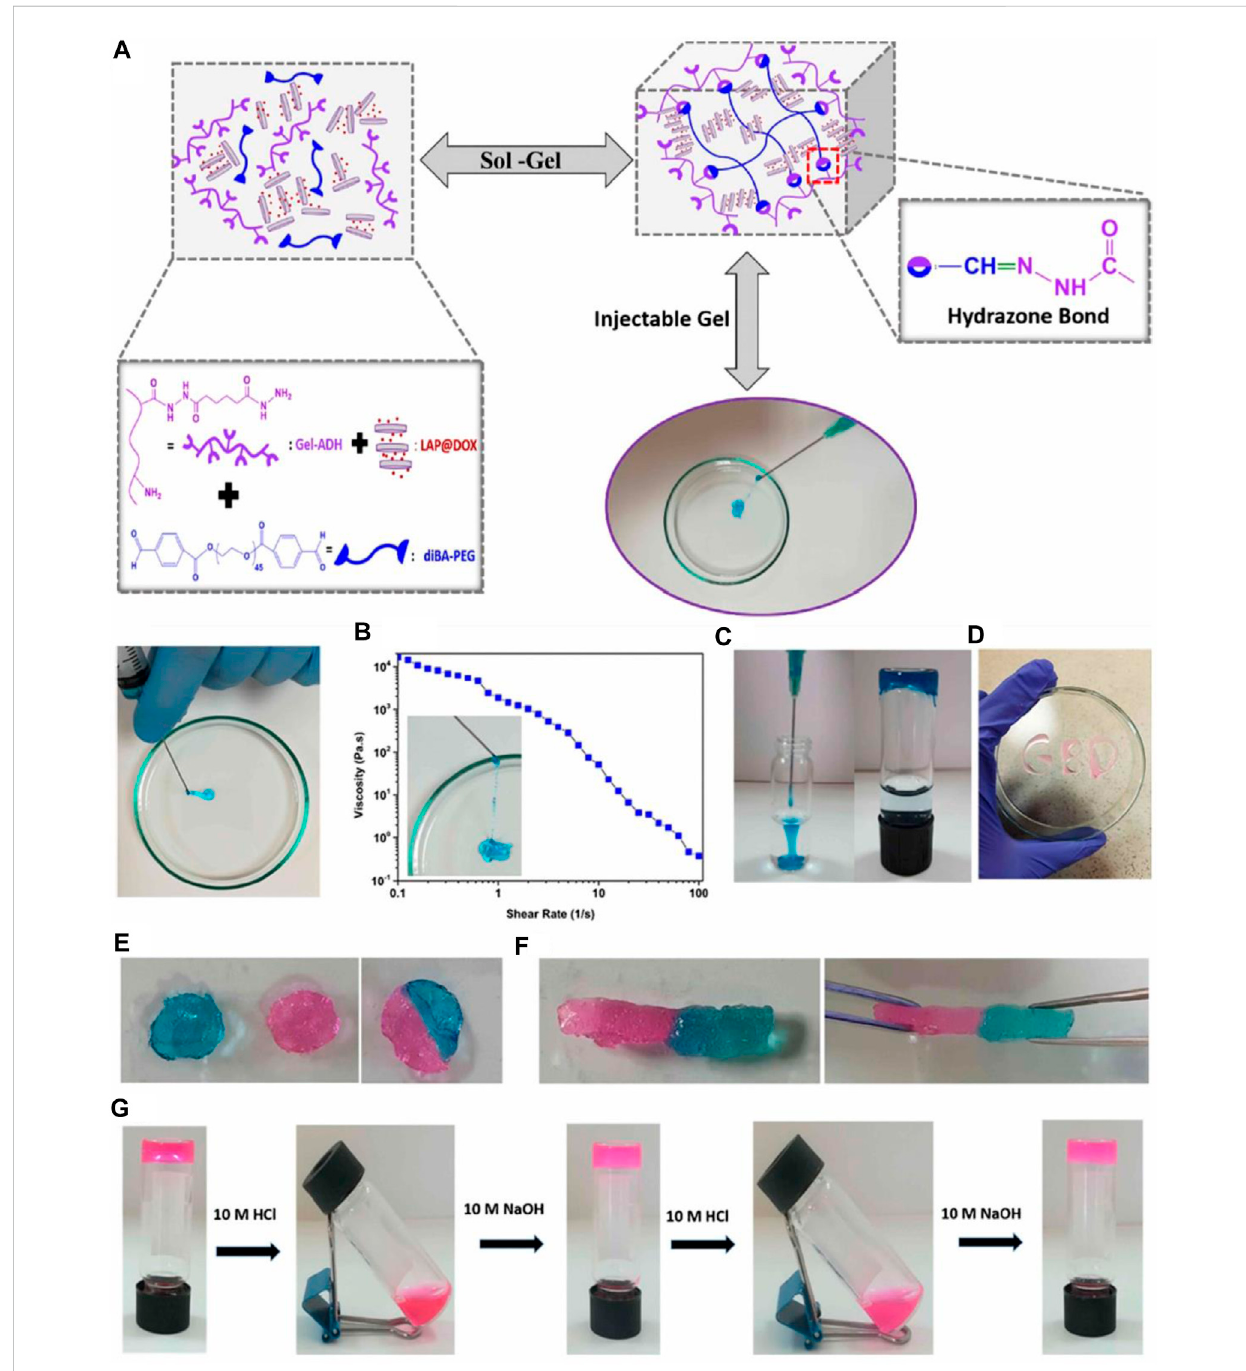
FIGURE 7 Injectability of the hybrid hydrogel: (A) hybrid hydrogel was injected through a 21-gauge needle, (B) diagram of the apparent viscosity rheology as a functionoftheshearrateofthehybridhydrogels. (C) InjectionoftheGel-ADH/diBA-PEG/LAPhybridhydrogelsintothePBSbufferandthephotographof the formed hydrogel into the PBS solution (D) Gel-ADH/diBA-PEG/LAP hybrid hydrogels injected from a 21-gauge needle onto a Petri dish. Self-healing behavior of the Gel-ADH/diBA-PEG/LAP hybrid hydrogels: the hybrid hydrogel was prepared in two colors, that is, pink and blue, separately, and these two-hybrid hydrogels were allowed to make contact with each other (E) photograph of the self-healed hydrogel after 1 h, and (F) stretching behavior of the self-healing hydrogel after 1 h (G) pH-dependent decomposition − composition behavior of the hybrid hydrogels. Reprinted with permission from (Cimen et al., 2021). Copyright 2021 American Chemical